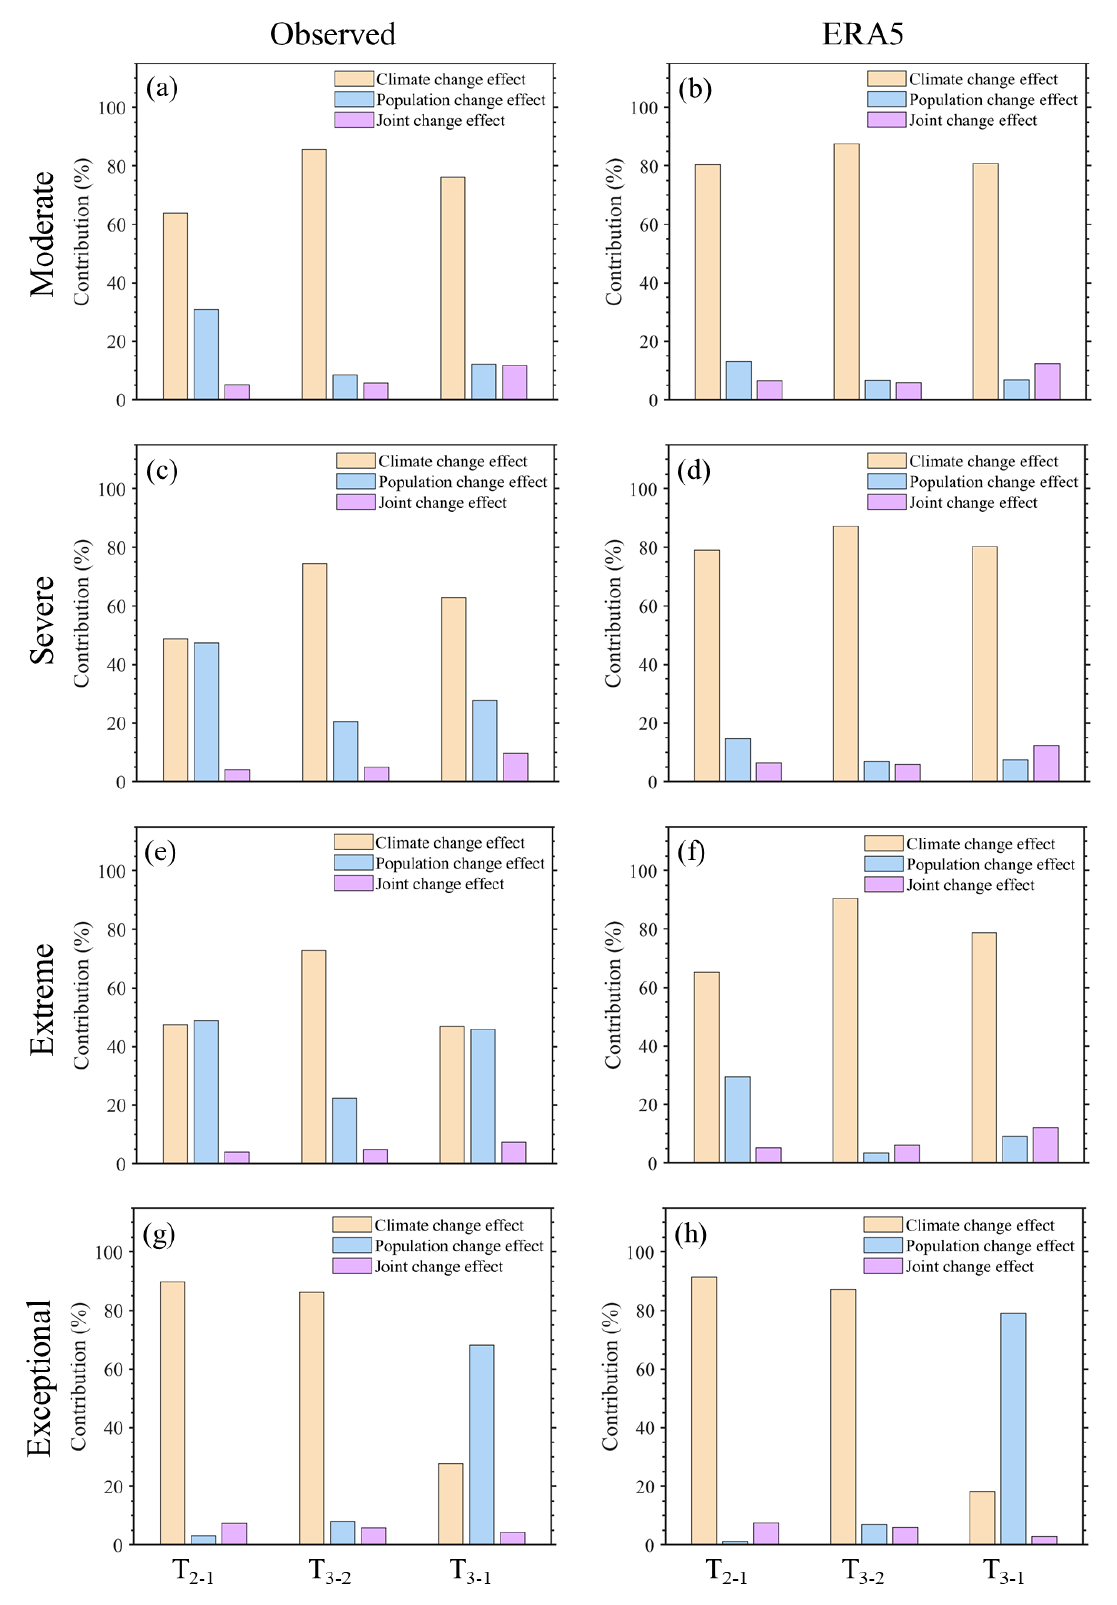
Figure 14. The same as Figure 13, but for CDHW frequency exposure at ( a , b ) moderate, ( c , d ) severe, ( e , f ) extreme, and ( g , h ) exceptional grades.